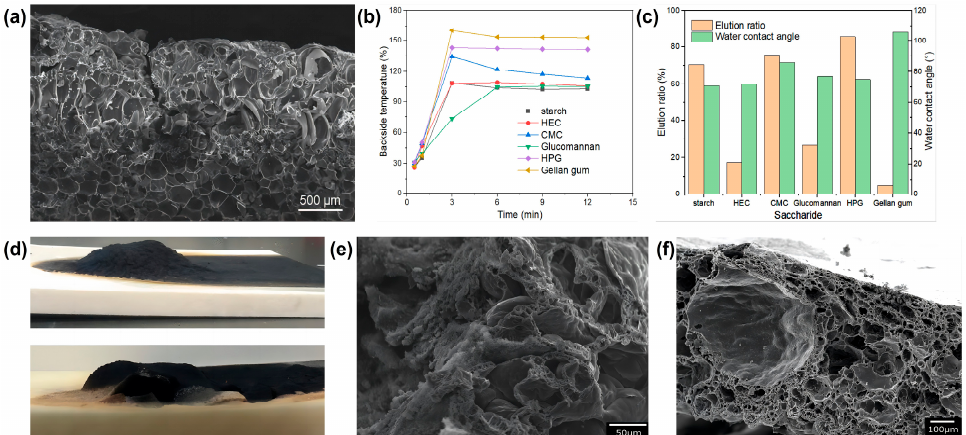
Figure 11. ( a ) SEM micrograph of the cross-sectional SPB/starch mixture coated RPUF after heating for 12 min in the pre-mixed flame. ( b ) Backside temperature versus time curves of the different coatings. ( c ) Water contact angles and elution ratios of the coatings (SPB mixed with different saccharides) on the surface of RPUF [65]. ( d ) The appearance of the coated RPUF ( top : SPB/HEC; bottom : SPB/gellan gum) after sustaining 12 min of heating in the pre-mixed flame. ( e ) SEM micrograph of the cross-sectional carbon residue of SPB/HEC mixture-coated RPUF. ( f ) SEM micrograph of the cross-sectional carbon residue of SPB/gellan gum mixture-coated RPUF [66].